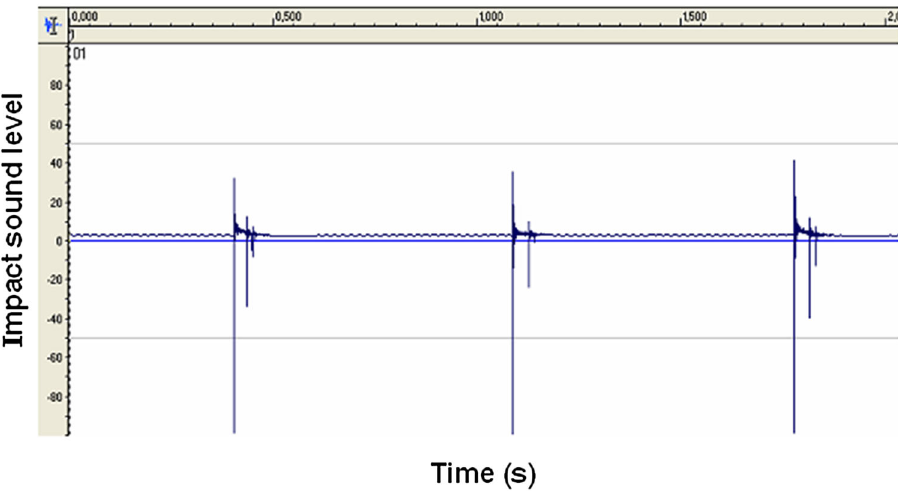
Fig. 11 Transversal vibration of the plate.